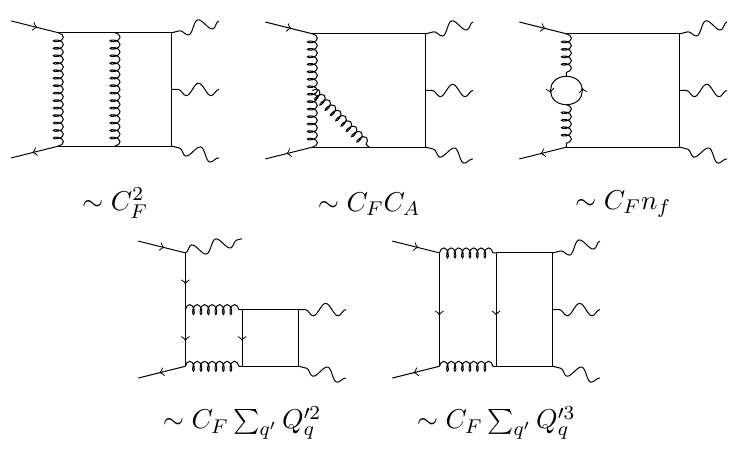
Figure 1 . Representative two-loop diagrams and their color/charge